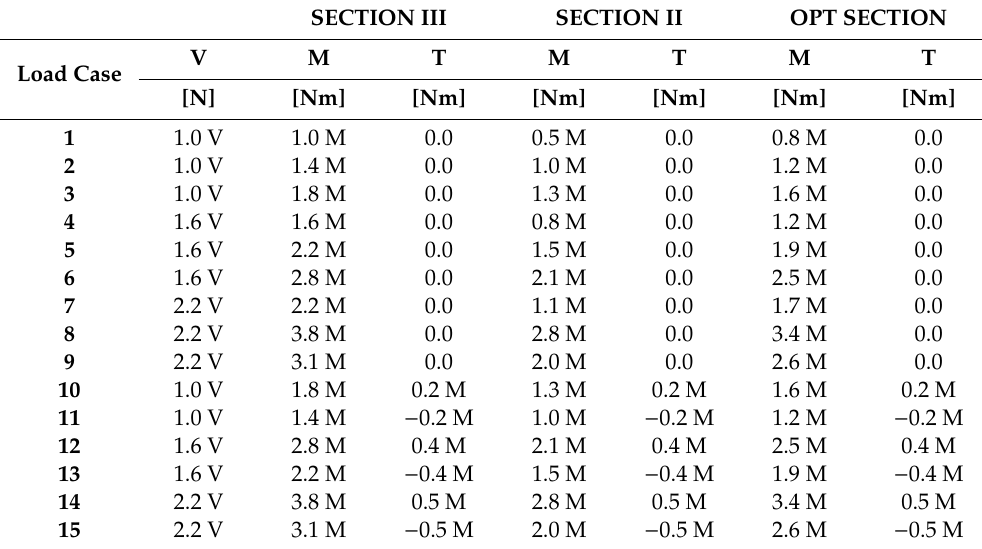
Figure 7. Points of application of force (The digits in the figure refer to the load cases in Table 1). Table 1. Experimental load